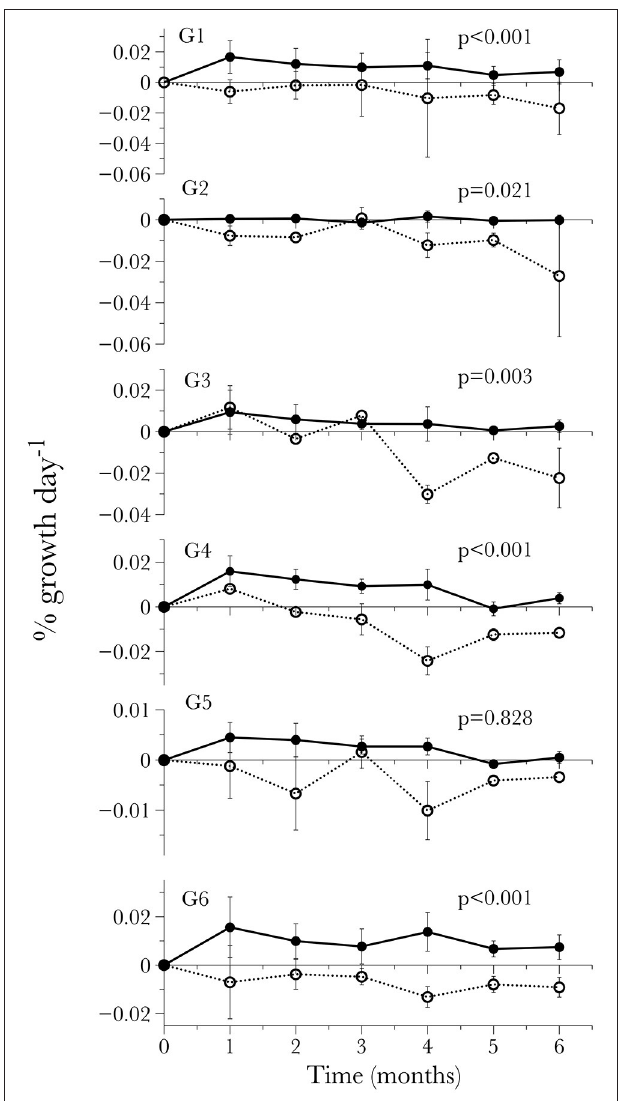
FIGURE 3 | Long-term time-series of the calcification response by individual genotype standardized by initial weight for each time-point. Values are given as mean ± S.D .